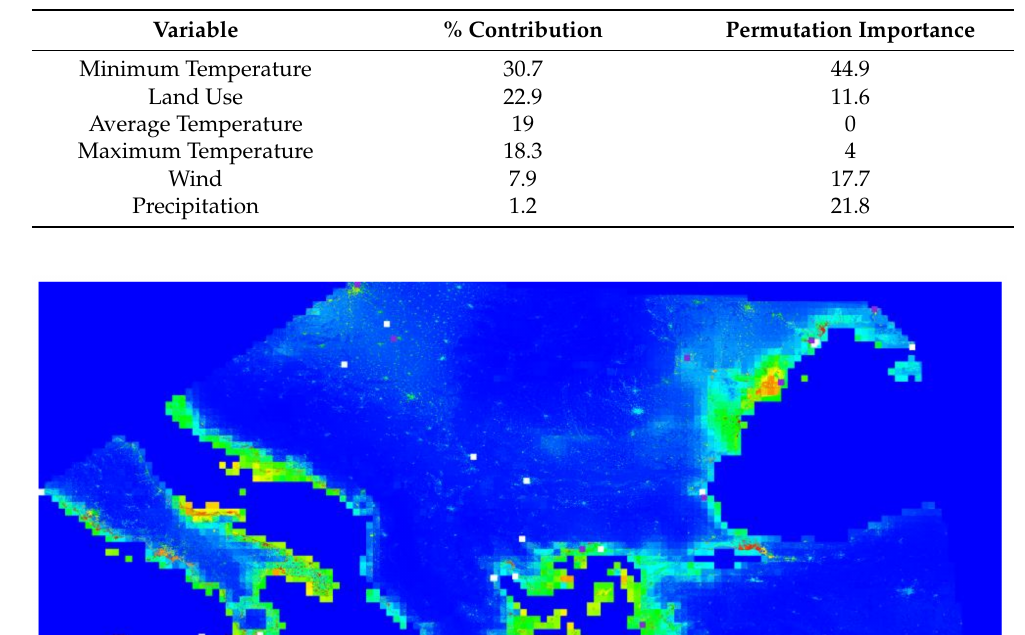
Table 3. Relative importance of the various factors associated with the presence points in a MAXENT modelling on the potential distribution of Anoxia orientalis in Europe.